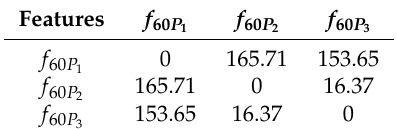
Table 3. Euclidean Distance Matrix Calculated for Selected Features (Table 2) for 60 Hz Power ENF